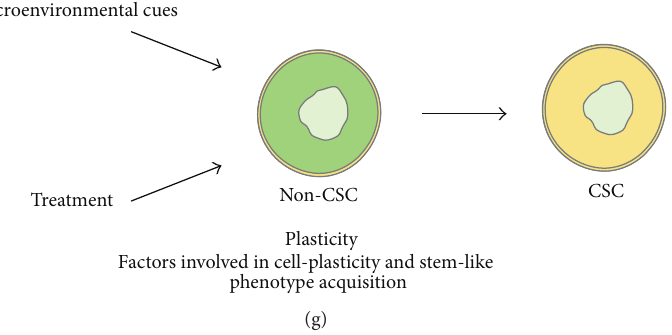
Figure 2: Mechanisms of CSCs’ therapy resistance and relevant biological targets. ((a)-(b)) Increased self-renewal and prosurvival signaling have been reported for CSCs. Molecules involved in self-renewal/survival as well as antiapoptotic proteins overexpressed in CSCs are potentially interesting targets for therapies seeking CSC elimination. Hh: Hedgehog; SMO: Smoothened; Ptch1: Patched; Dll: Delta-like ligand; Wnt: wingless integration site; Fz: Frizzled; LRP: low-density lipoprotein receptor-related protein; BMI1: polycomb ring finger; BCL- XL: B-cell lymphoma extra-large; BCL2: B-cell lymphoma 2. (c) CSCs respond with higher efficacy to DNA damage via checkpoint